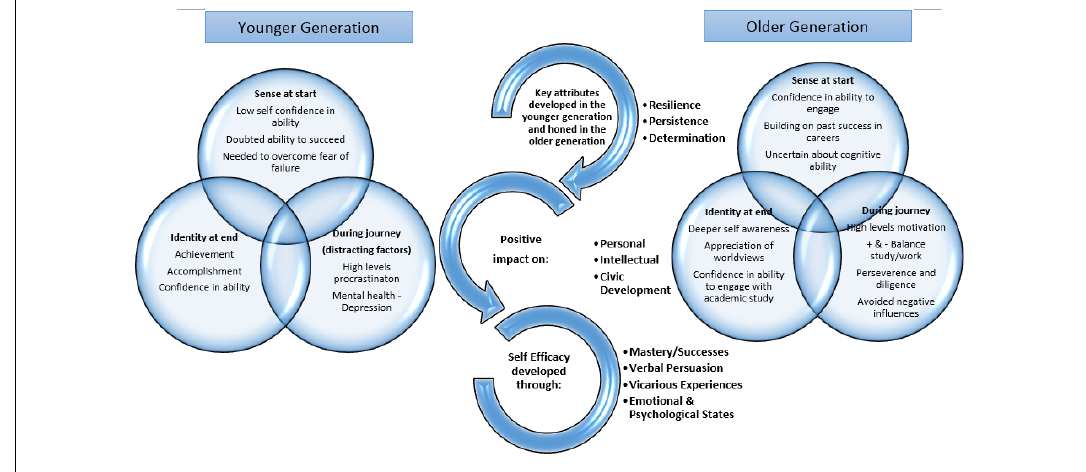
Figure 2: Development of Self